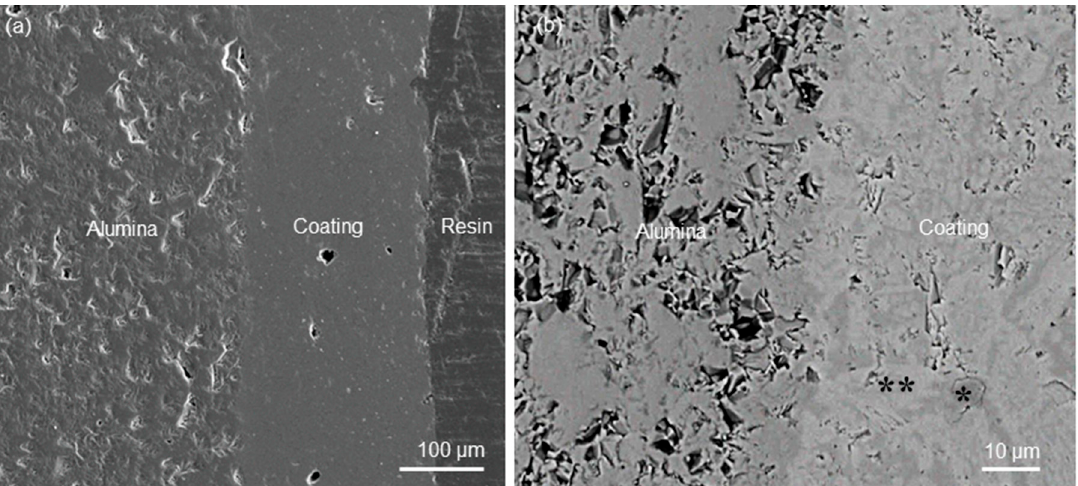
Figure 3. Analysis of the coating cross section: ( a ) SEM micrograph in “secondary” mode (400×) and ( b ) high-magnification detail (2500×) inspected in back-scattering mode showing the interface between coating and alumina as well as the coating microstructure (glass–ceramic nature); the white areas (**) correspond to the wollastonite crystals, while the dark zones (*) correspond to the residual glassy phase. Table 1. Mechanical properties of the coatings.